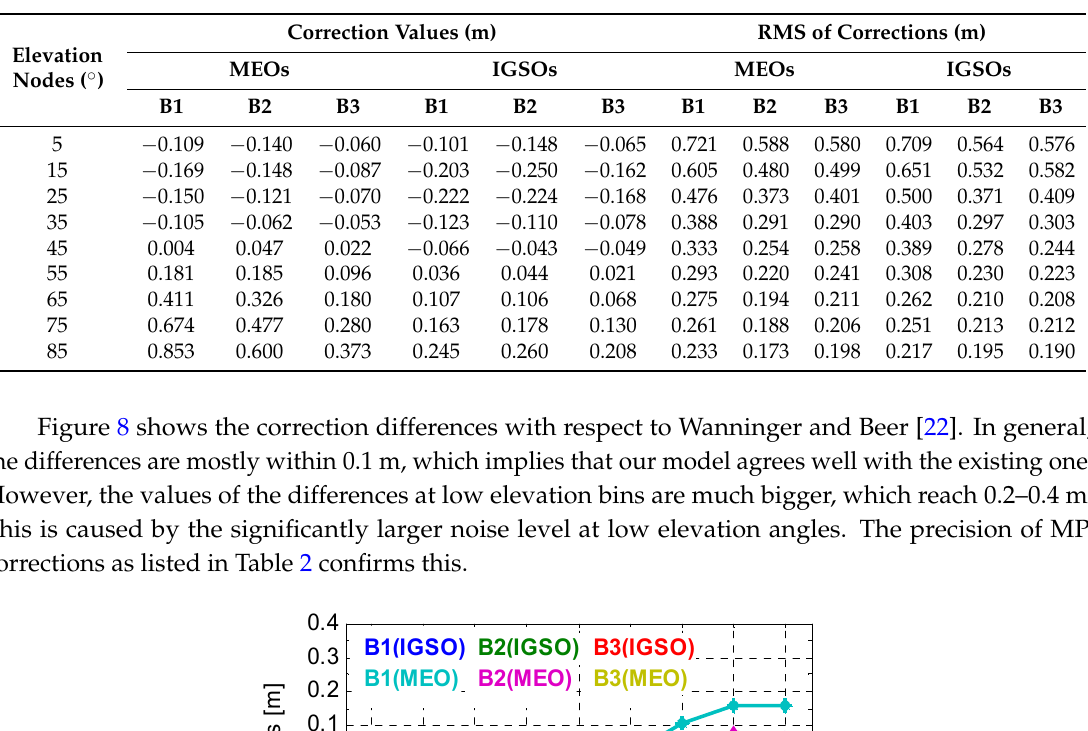
Table 2. Correction values and their precisions for BeiDou MEO/IGSO code measurements.